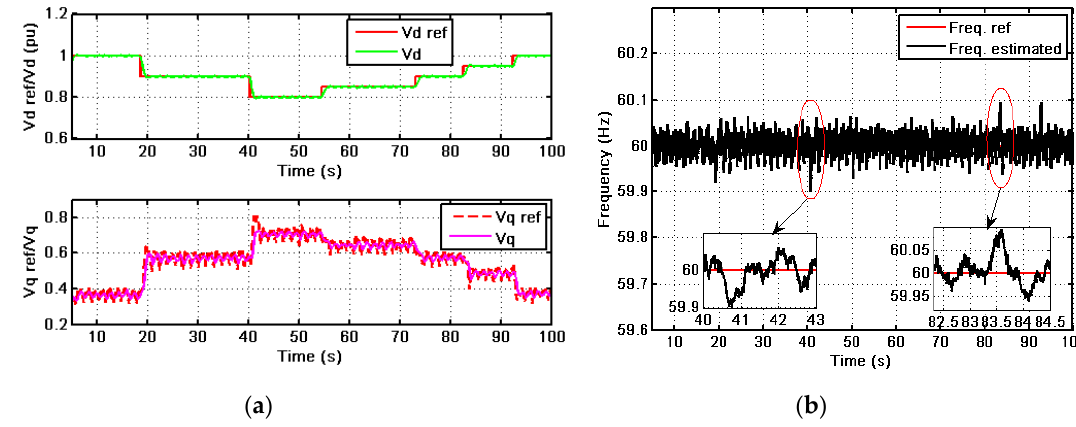
Figure 12. Load side control: ( a ) Controlled d-q load voltages, ( b ) Frequency control and estimation.